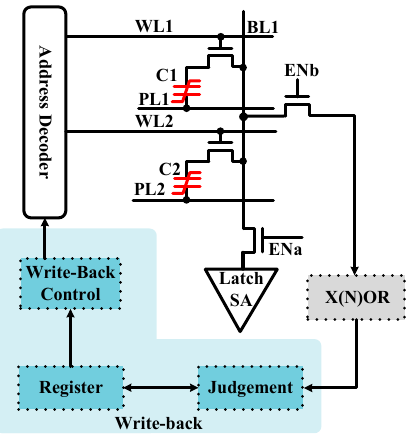
Figure 10. Schematic of the write-back module.